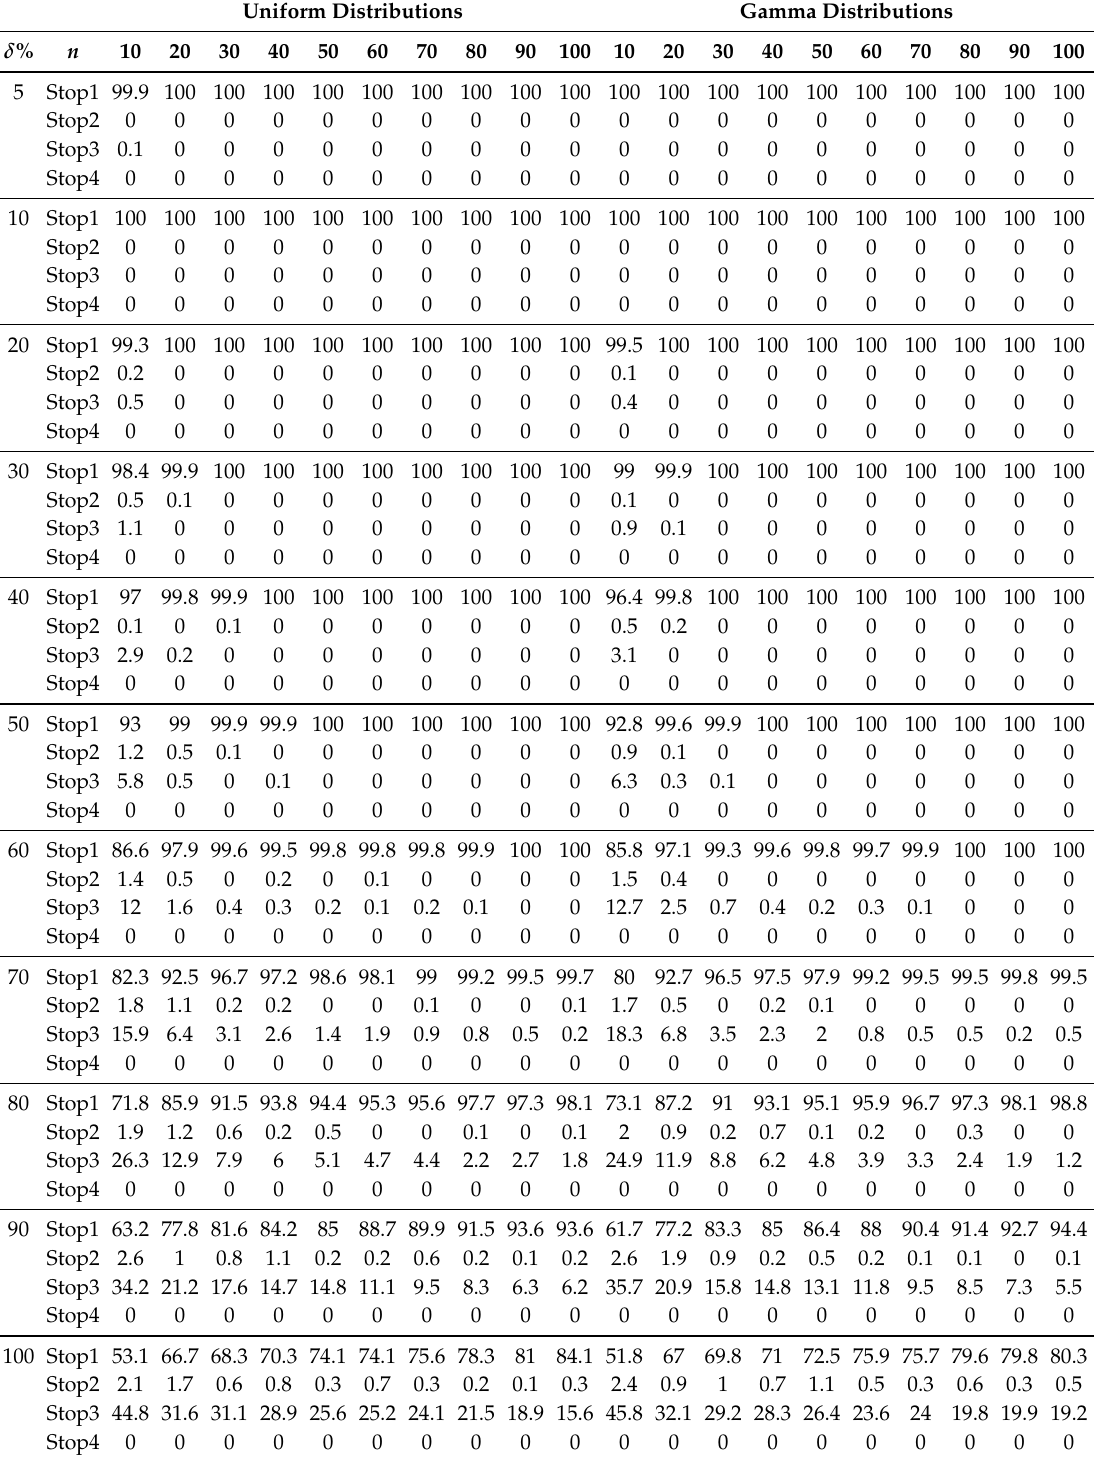
Table A10. Computational results for randomly generated instances with the ratio 10%:10%:40%:40% of the numbers of jobs in the subsets J 1 , J 2 , J 1,2 and J 2,1 of the job set J . Uniform